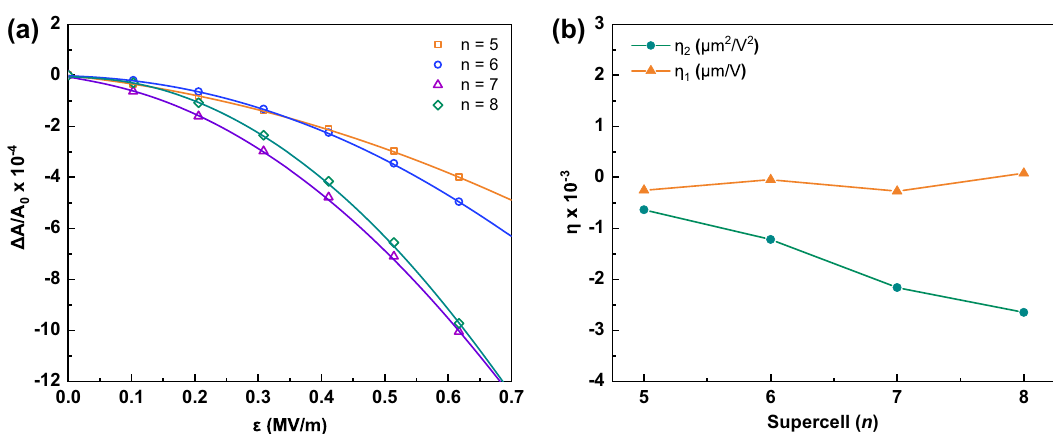
Fig. 4 Electric fi eld dependent hyper fi ne coupling. a Electric fi eld response of hyper fi ne coupling 4 A = A 0 as a function of the intensity of external electric fi eld ( ε ) for various supercell sizes ( n ), where 4 A represents the change of hyper fi ne parameter in the presence of electric fi eld (i.e., A ε ð Þ (cid:2) A represents the hyper fi ne parameter without electric fi eld; b quadratic ( η 2 ) and linear ( η 1 ) coef fi cients as a function of